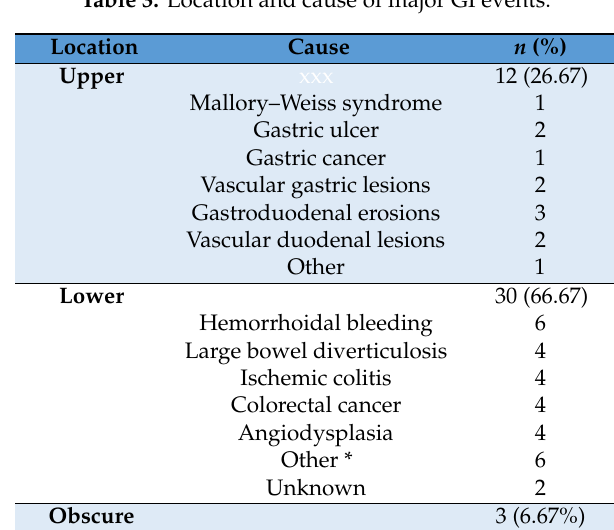
Table 3. Location and cause of major GI